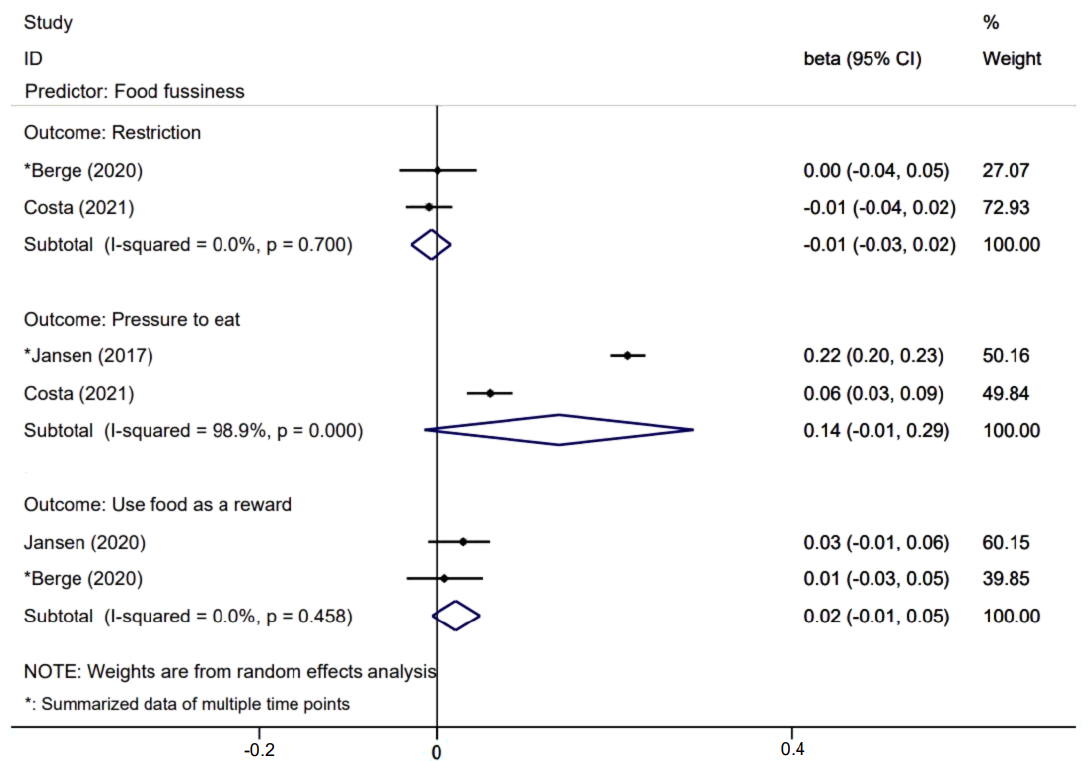
Figure 5. Effects of child food fussiness on parental non-feeding practices.